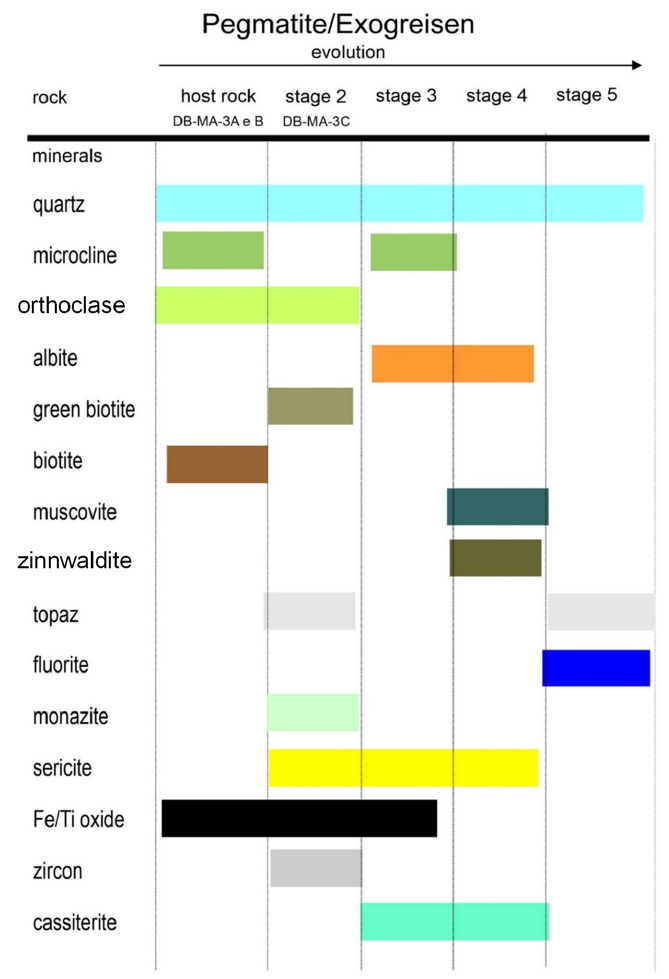
Figure 16. Mineral paragenesis was obtained by petrographic analysis of samples related to pegmatites and exogreisens.